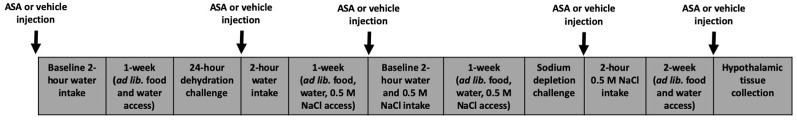
A timeline of the experimental procedures.